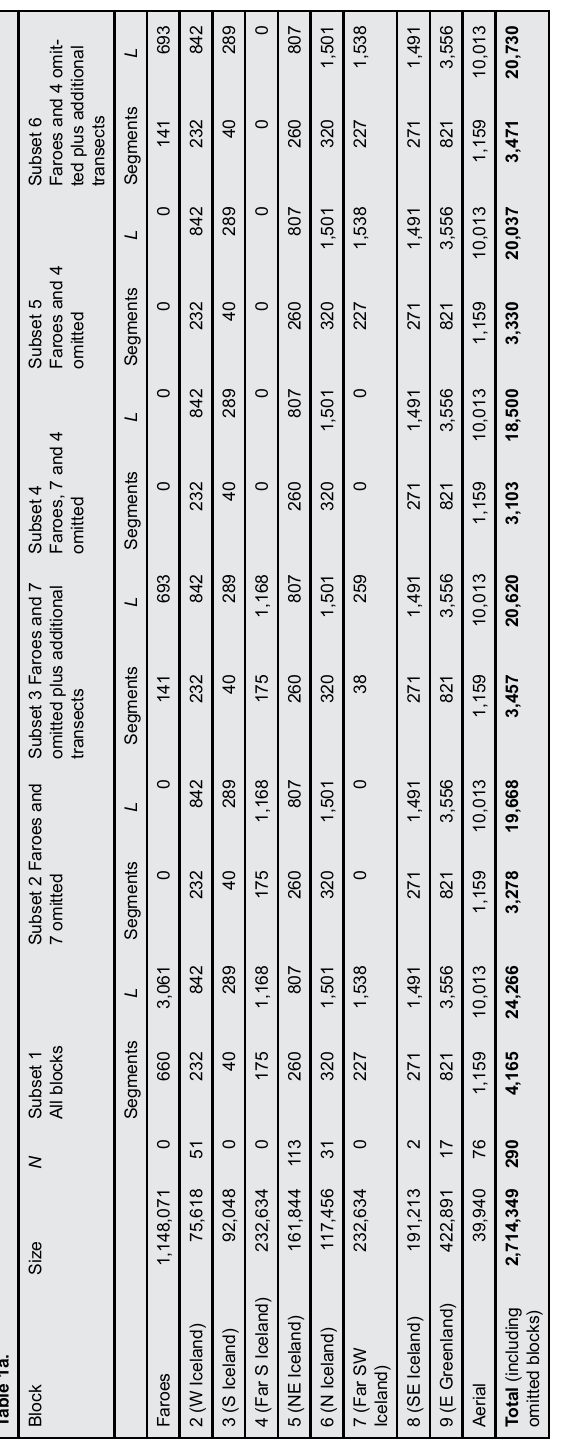
Table 1a and 1b. For each survey block, area in km², number of sightings after truncation ( N ), number of segments and real- ised search effort ( L ) in km for a) 1995 and b) 2001. Search effort is realised effort after discarding effort conducted in Beaufort Sea States greater than 6 and anomalous